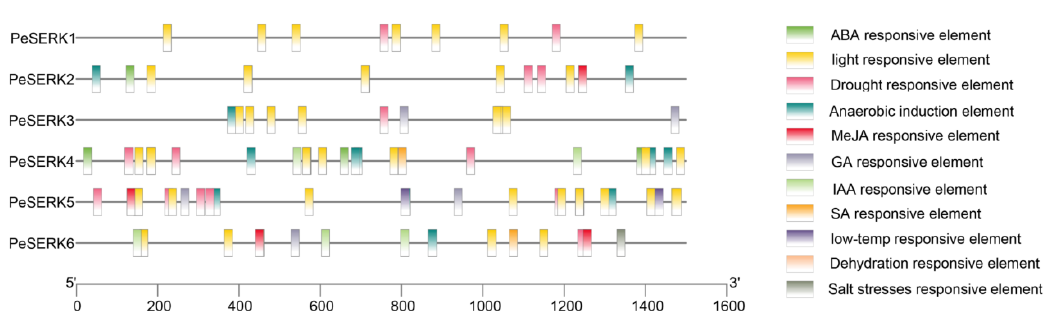
Figure 6. Cis-acting element analysis of PeSERK promoters. The 1500 bp sequence upstream of the PeSERK start codon was analyzed using PlantCARE. Binding sites in the promoter region are represented by boxes of different colors, and the graph shows the number of binding sites.